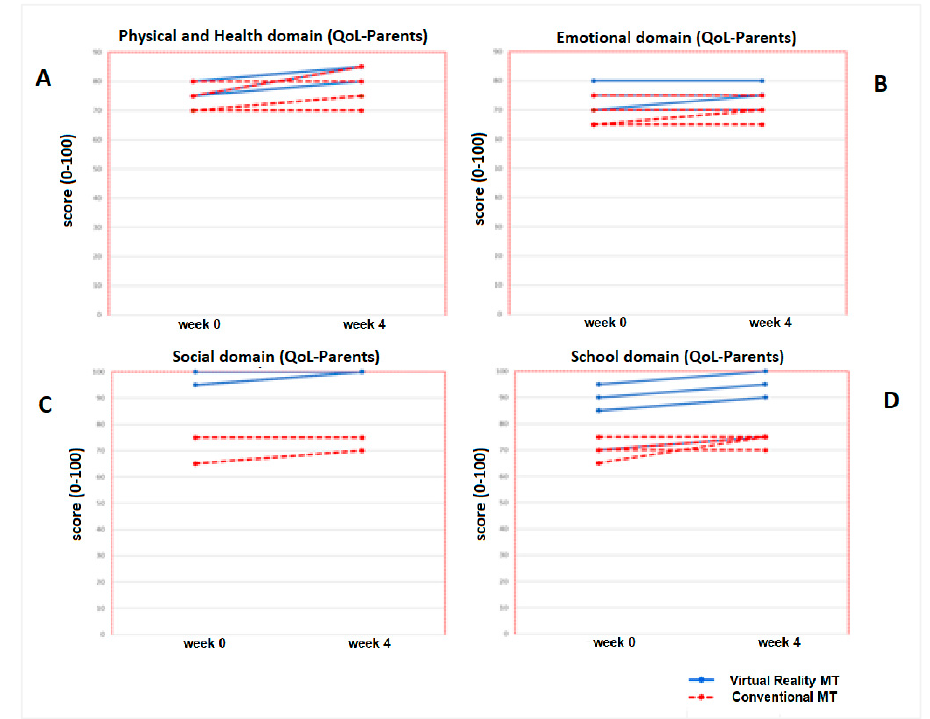
Figure 7. Progression of Quality of Life-Parents (domains) in the five children of the Virtual Reality MT and the five children who performed Conventional MT. In the picture ( A ), it can be seen the progression of the Physical and Health domain and in the picture ( B ), the Emotional domain evolution. In the picture ( C ), the progression of the Social domain is represented and the picture ( D ), the school domain evolution.